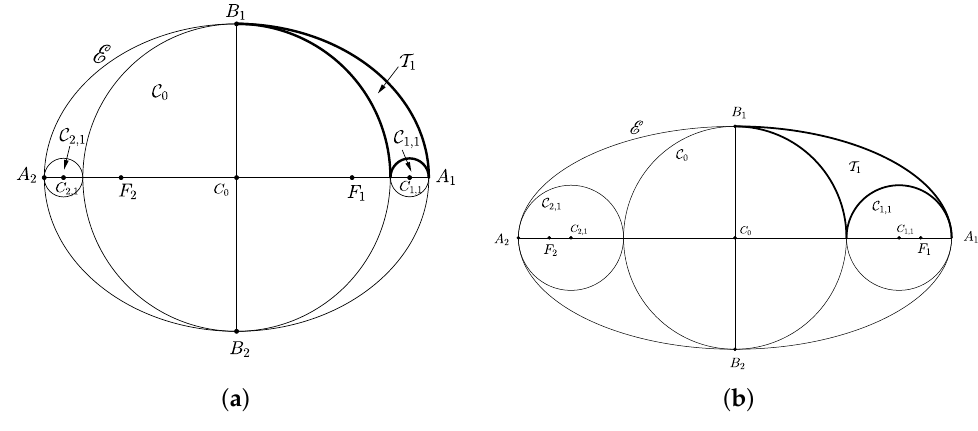
Figure 1. Scaffoldings for ellipses with a / b = 5/4 ( a ) and a / b = 2 ( b ).